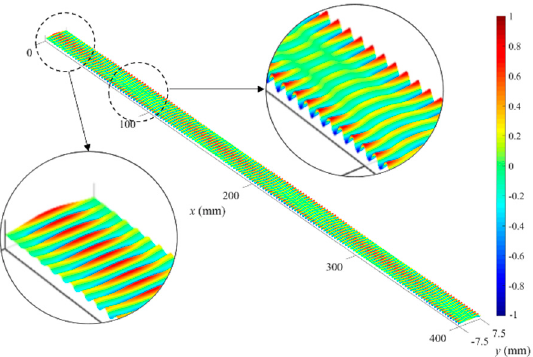
Figure 11. Change of wave phase on the waveguide plate by the mode superposition between the A(0,0) and A(0,2) modes.